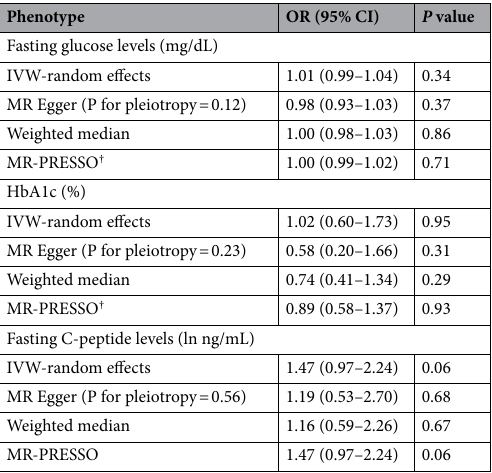
Table 2. Mendelian randomisation analysis of glycaemic traits with colorectal cancer risk. † One outlier was detected and corrected in the MR-PRESSO analyses for fasting glucose and HbA1c. CI confidence interval, HbA1c haemoglobin A1c, IVW inverse-variance weighted, MR Mendelian randomisation, PRESSO Pleiotropy Residual Sum and Outlier, OR odds